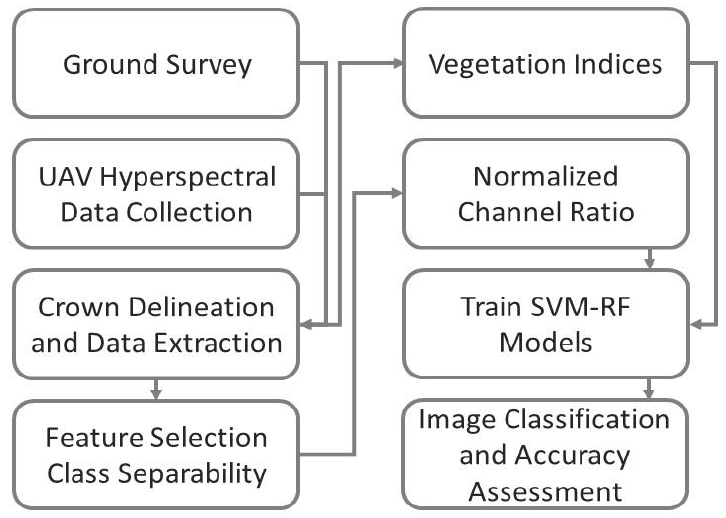
Figure 2. Workflow of data analysis in this study.